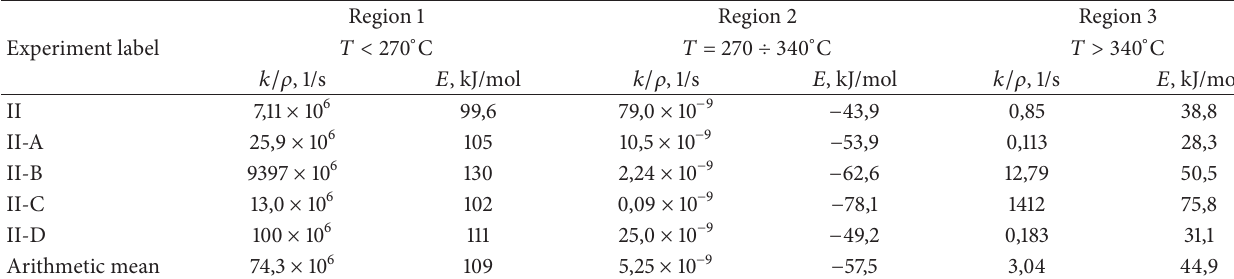
Table 5: Kinetic parameters of wheat straw for the reference set.